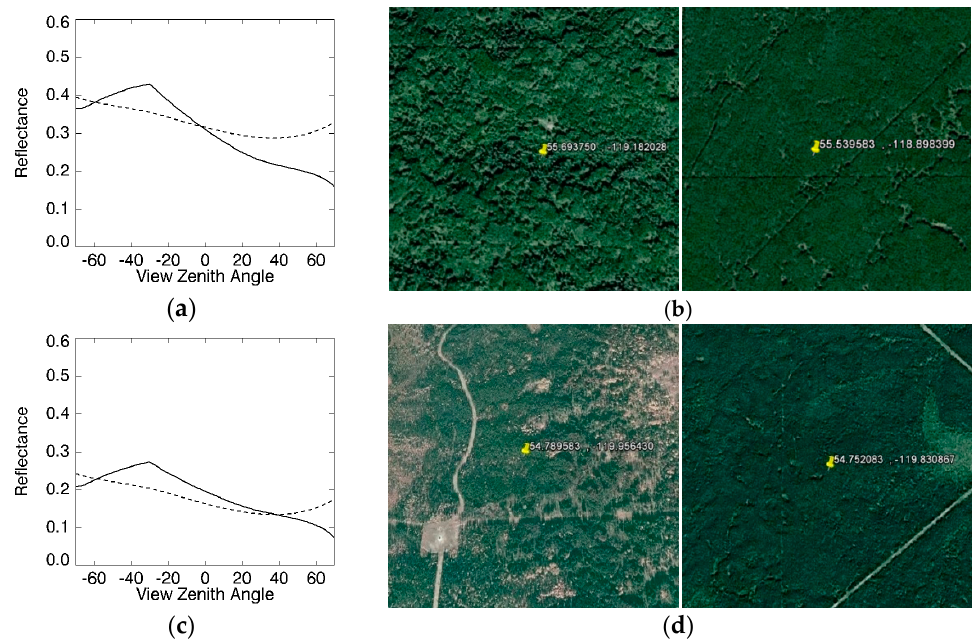
Figure 3. MODIS BRDF shape in the principal plane ( a ) for the deciduous broadleaf forest ( b ) and the one ( c ) for evergreen needle forest ( d ) images at two pixels in the NIR band. The solid lines refer to the BRDF shapes of the images on the left, and the dashed lines refer to the BRDF shapes of the images on the right.